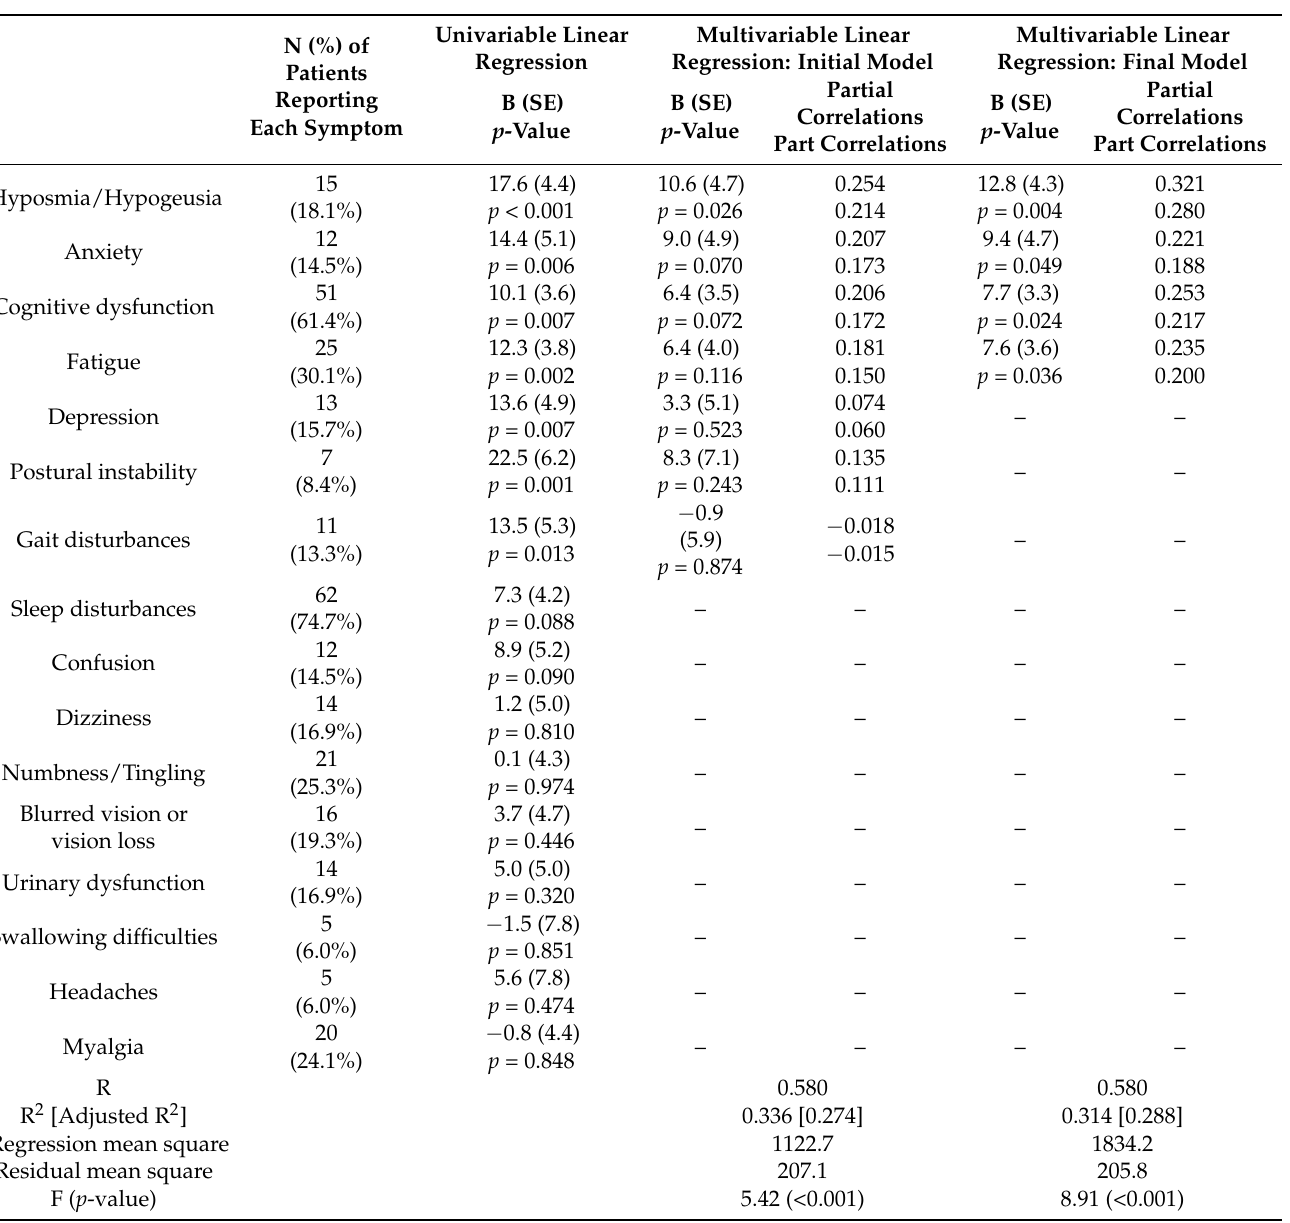
Table 2. Prevalence of brain-related symptoms among COVID-19 survivors and regression model predicting WHODAS-12 variation. N (%)